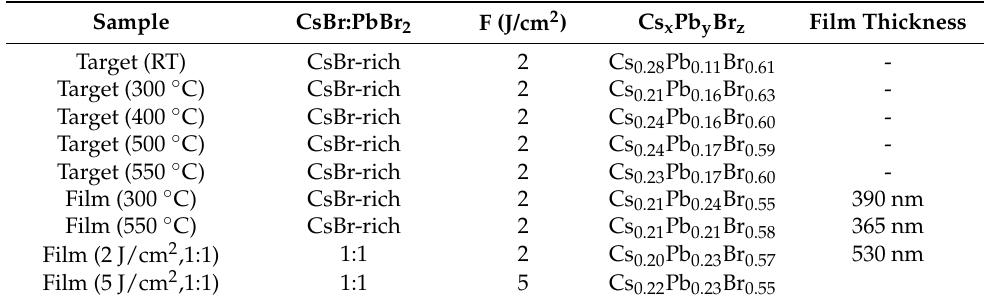
Table 1. Preparation parameters of the mechanochemically synthesized targets and PLD-deposited films under consideration in this study according to the nomenclature defined in the Experimental section. The composition of the targets was estimated by EDS. The composition of Film (300 ◦ C) and Film(550 ◦ C) was calculated by EDS. The composition of Film (2 J/cm 2 , 1:1) and Film (5 J/cm 2 , 1:1) was measured by